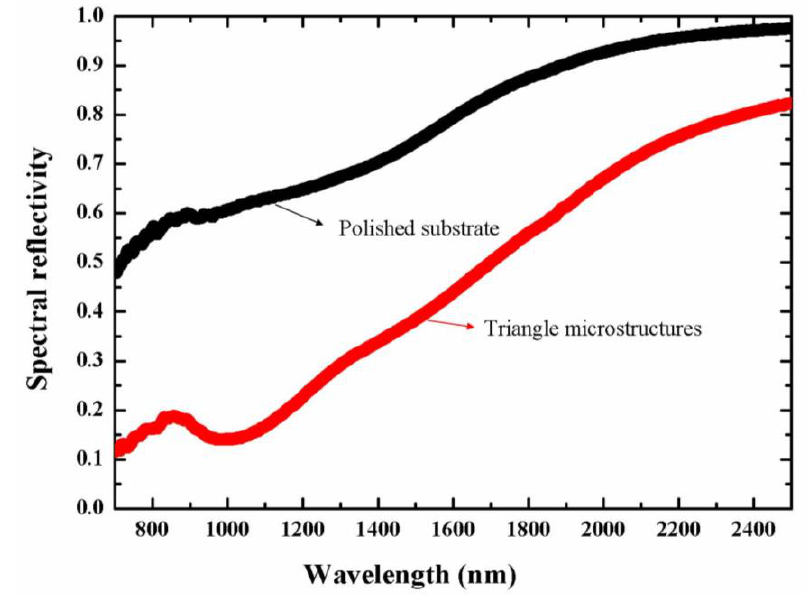
Figure 4. Measured reduction of the optical reflectivity for tungsten surfaces covered with subwavelength triangular structures (red solid line) in comparison with the polished surface (black solid line).